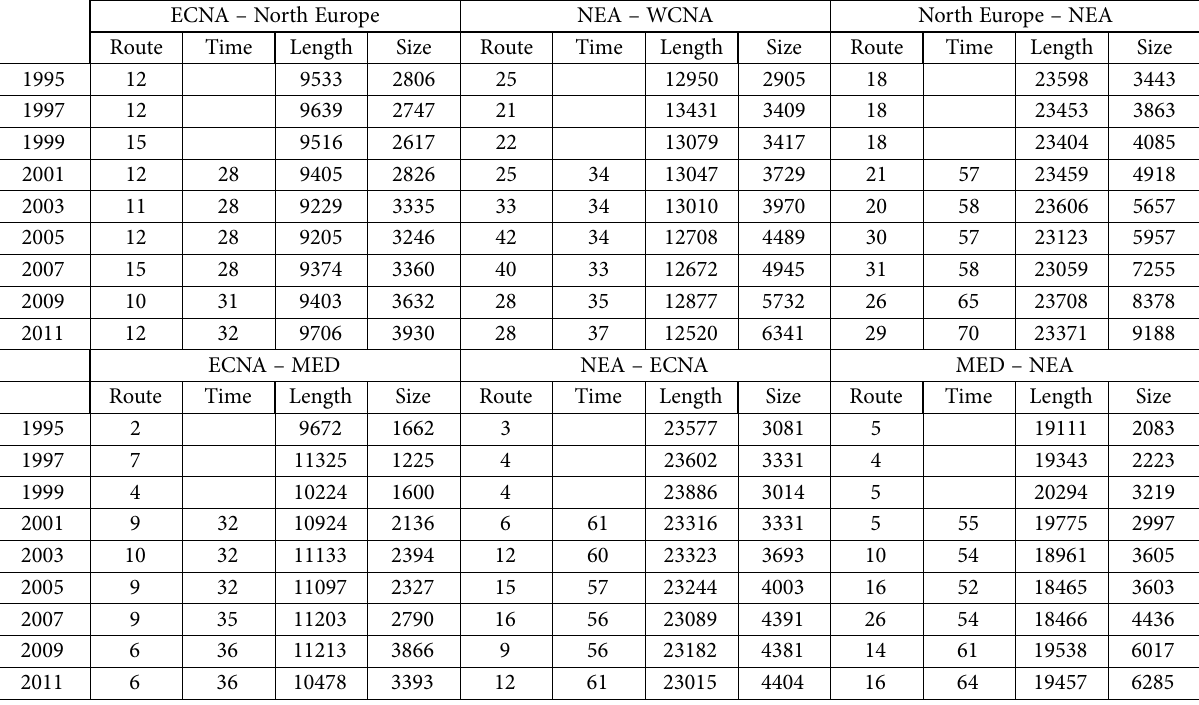
Table 3. Operational parameters of major ETE routes